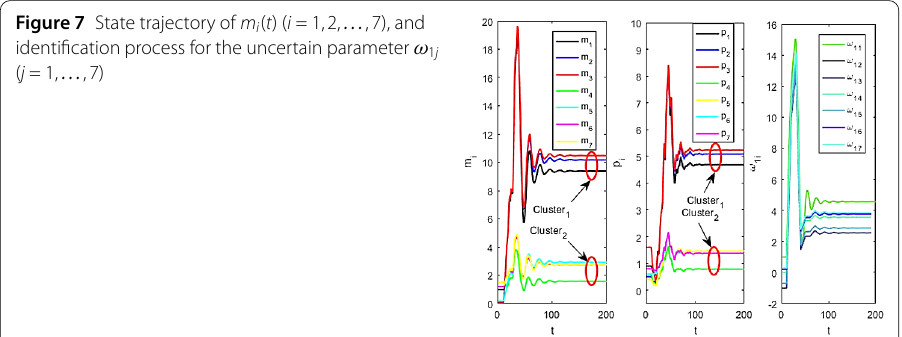
Figure 7 State trajectory of m i ( t ) ( i = 1,2, ... ,7), and identification process for the uncertain parameter ω 1 j ( j = 1, ...